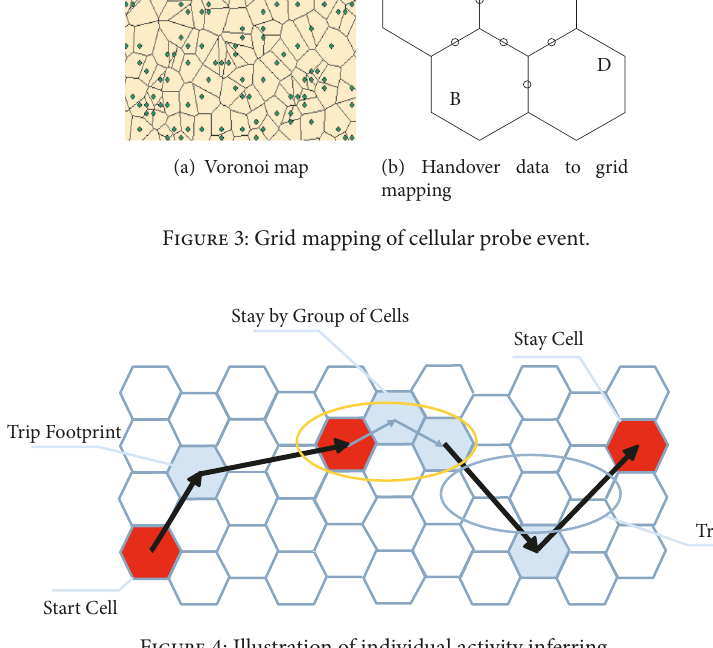
Figure 4: Illustration of individual activity